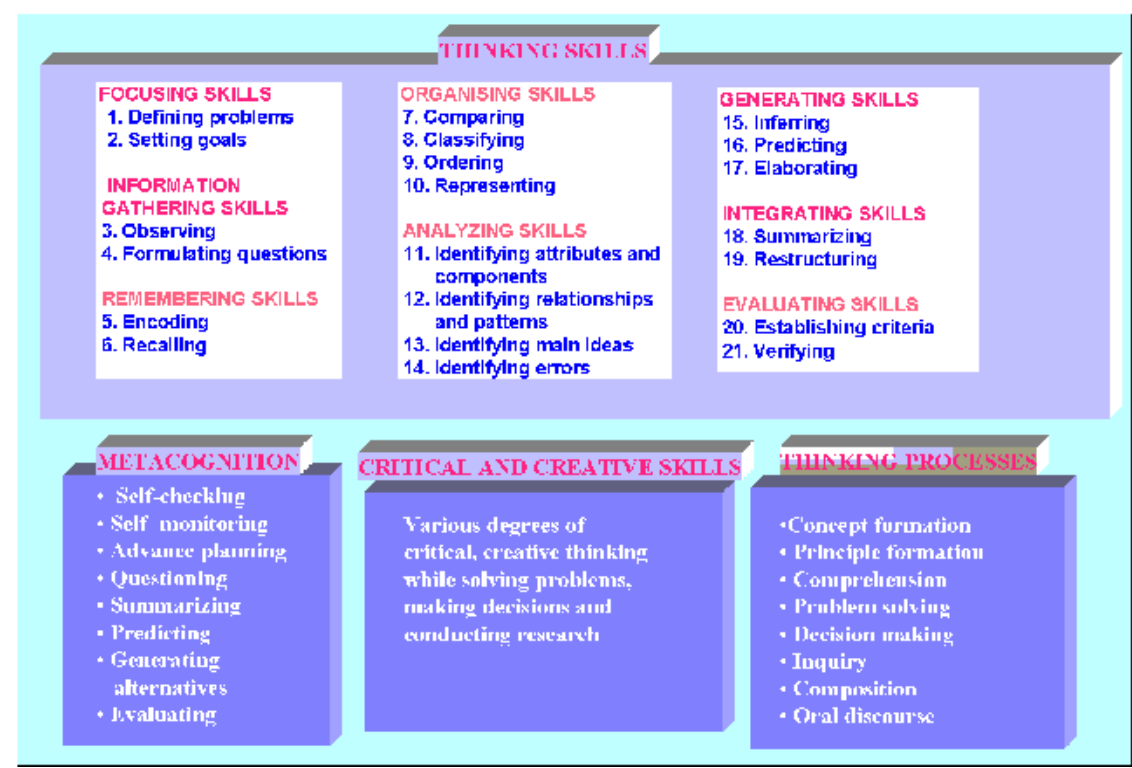
Figure 4 Model of design skills (Carver et al .,